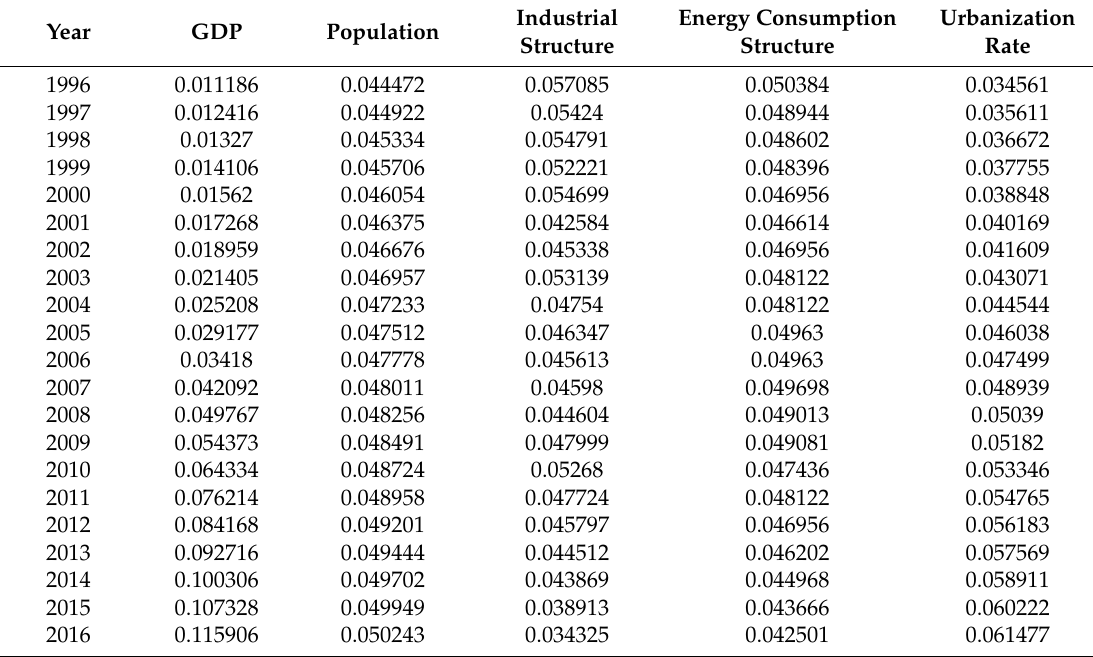
Table 4. The main factors’ normalized results.